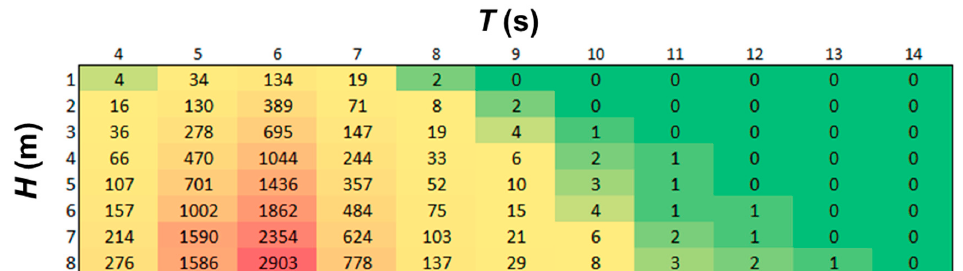
Figure 4. Power matrix associated with the WWF SWEDE wave generator. Information processed from [38], where the output power is in kW (green colour indicates zero or small values, yellow average and red high power values).